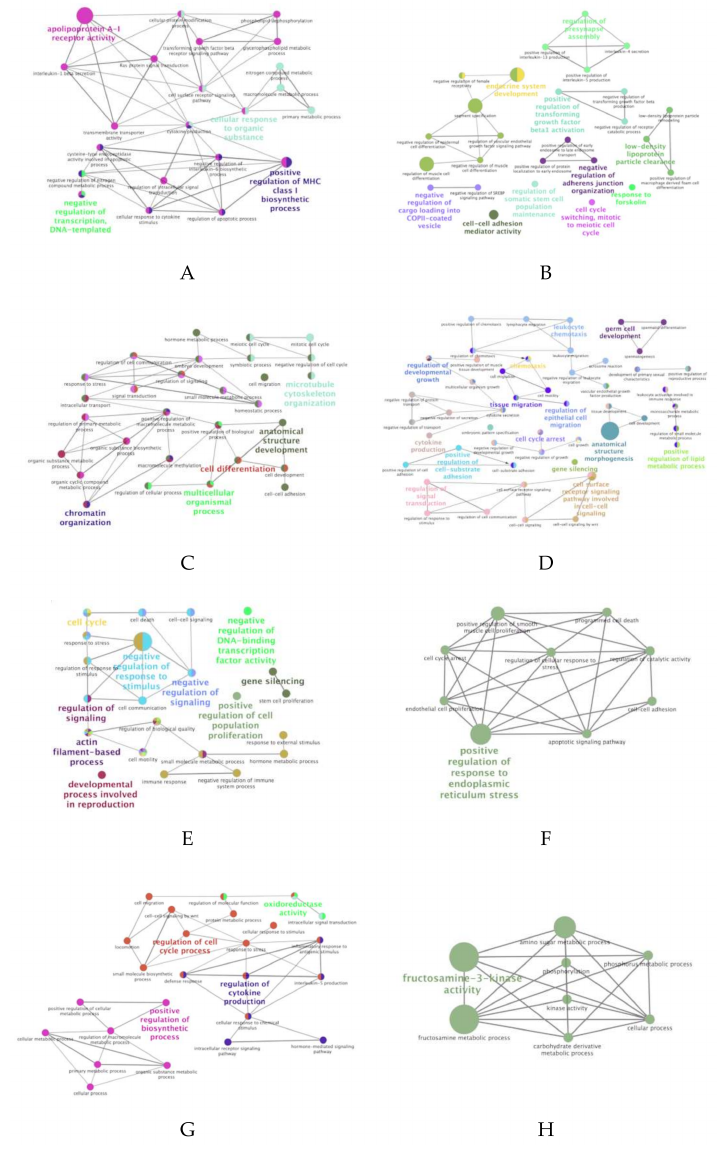
Figure6. Schematicrepresentationofbiologicalprocessesassociatedwithtargetgenesofdownregulated microRNAs (miRNAs) (( A ): miR-23a-5p, ( B ): miR-34b, ( C ): miR-34b-3p, ( D ): miR-205, ( E ): miR-4776-3p, ( F ): miR-3944-3p) and upregulated (( G ): miR-92b-5p, ( H ): miR-574-5p) identified in media of explants (uterus and / or utero-tubal junction) exposed to Medium 199 (M199) supplemented with seminal plasma from di ff erent ejaculate fractions (sperm-rich fraction (SRF) and post-SRF) and the recomposed ejaculate, compared with its control (M199 alone). Cytoscape v3.0.0 application ClueGO v2.0.3 was used to perform the analysis of overrepresented functional categories. The following databases were used: Gene Ontology (GO) subgroups biological process. Terms are functionally grouped based on shared genes (kappa score) and are shown in di ff erent colors. The degree of significance is indicated by the size of the nodes: the biggest nodes correspond to the highest significance. The name of the group is defined by the most significant term. The following ClueGO parameters were used: biological process database (BP; date: 28.03.2019), GO tree levels, 2–5 (first level = 0), minimum number of genes, 2, minimum percentage of genes, 2, GO term fusion, GO term connection restriction (kappa score), 0.4, GO term grouping, initial group size of 2 and 50% for group merge. The resulting network was modified, which means that some redundant and unnecessary terms were removed and the network was manually